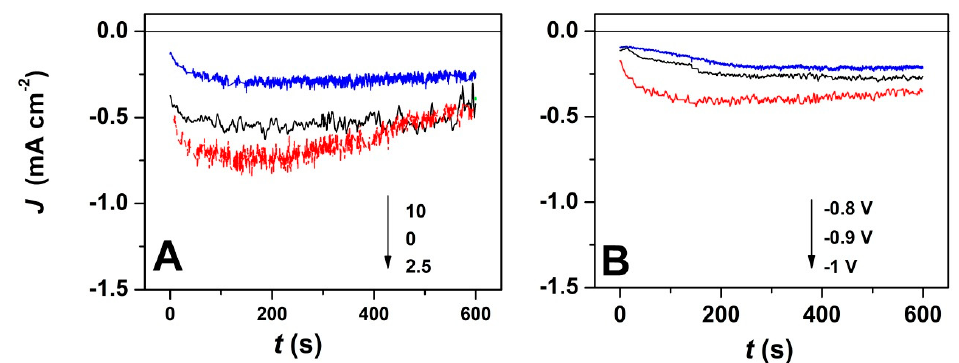
Figure 2. ( A ) Current transients for ZnO electrodeposition in presence of varying GO amount at an applied deposition potential of − 1 V; ( B ) Current transients for ZnO electrodeposition with applied deposition potential in the presence of 7.5 mg L − 1 GO.